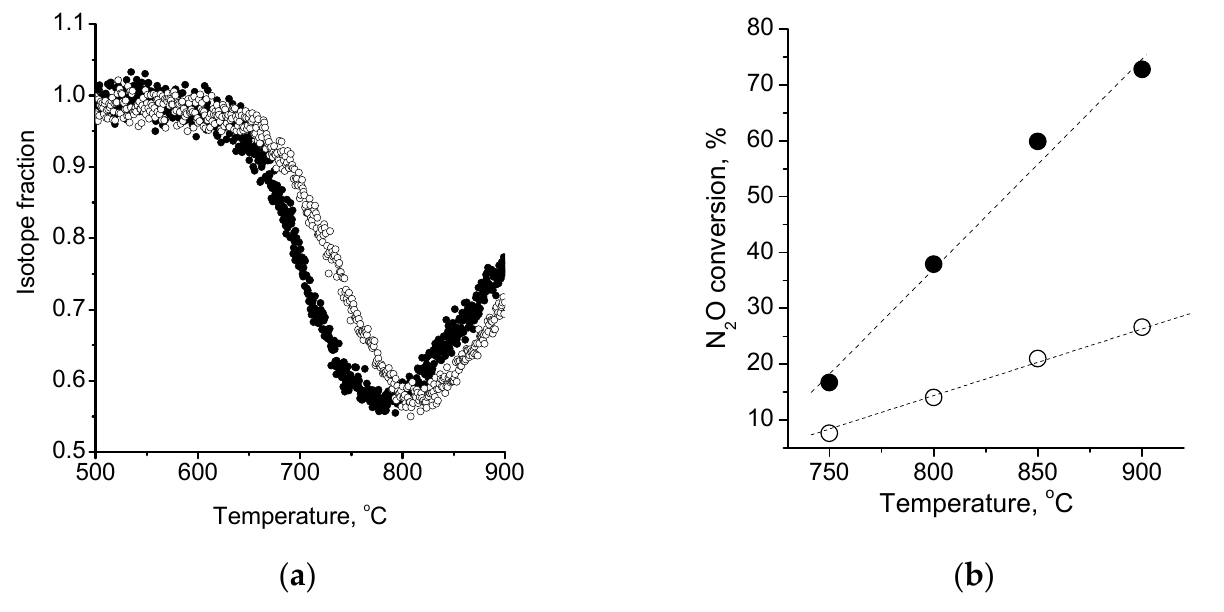
Figure 5. Oxygen isotope fraction during 18 O 2 TPIE ( a ) and N 2 O conversion variation with temperature ( b ) for FeO x /CeO 2 samples with different Fe content ( • —0.86 wt.% Fe, o—2.5 wt.% Fe). Inlet mixture composition: 0.15% N 2 O in He, 60 L/h.